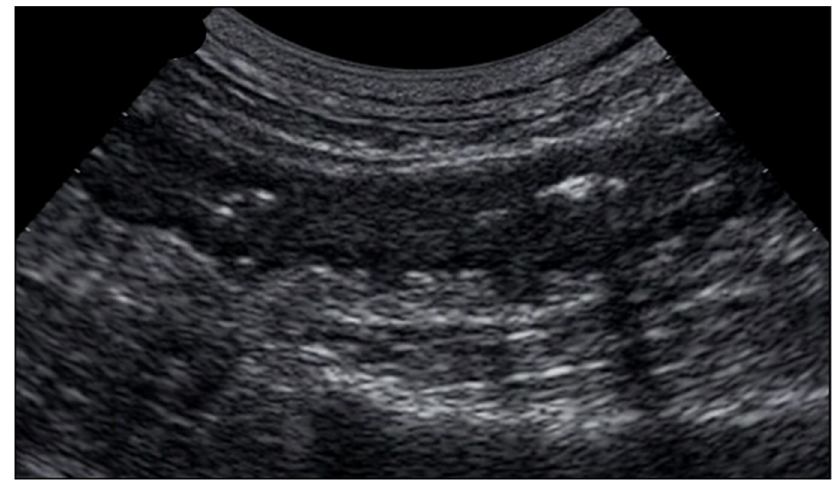
Figure 8. The image represents a section of the descending colon with diffusely thickened and hypoechoic walls; in particular, there are multiple outpourings of the wall, compatible with diverticula.